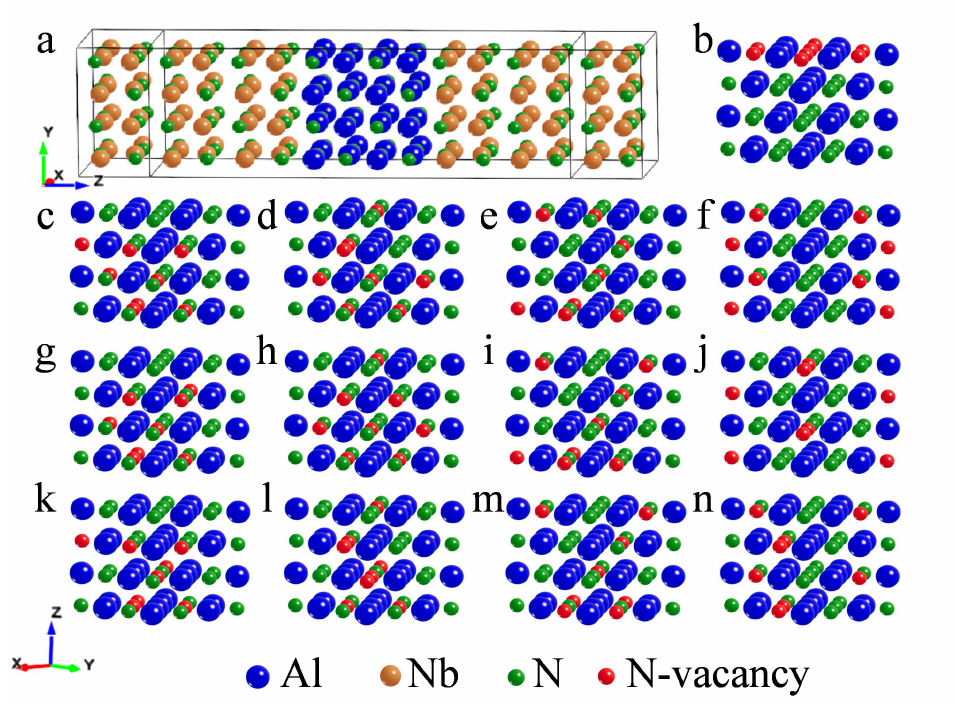
Figure 1. AlN vacancy distribution of barrier layer in model 3. Blue atom is Al, orange atom is Nb, green atom is N, and red atom is N vacancy. ( a ) the atomic structure of the barrier in defect-free model 3; ( b ) the vacancies of model 3b; ( c , g , k ) the vacancies distribution of the group 3c, including model 3c, 3c-com1, and 3c-com2. The number of atoms in each layer is 0, 3, 2, 3, respectively; ( d , h , l ) the vacancies distribution of the group 3d, including model 3d, 3d-com1, and 3d-com2. The number of vacancies of atoms in each layer is 1, 2, 3, and 2, respectively; ( e , i , m ) the vacancies distribution of the group 3e, including model 3e, 3e-com1, and 3e-com2. The number of vacancies of atoms in each layer is 2, 1, 1, and 4, respectively; ( f , j , n ) the vacancies distribution of the group 3f, including model 3f, 3f-com1, and 3f-com2. The number of vacancies of atoms in each layer is